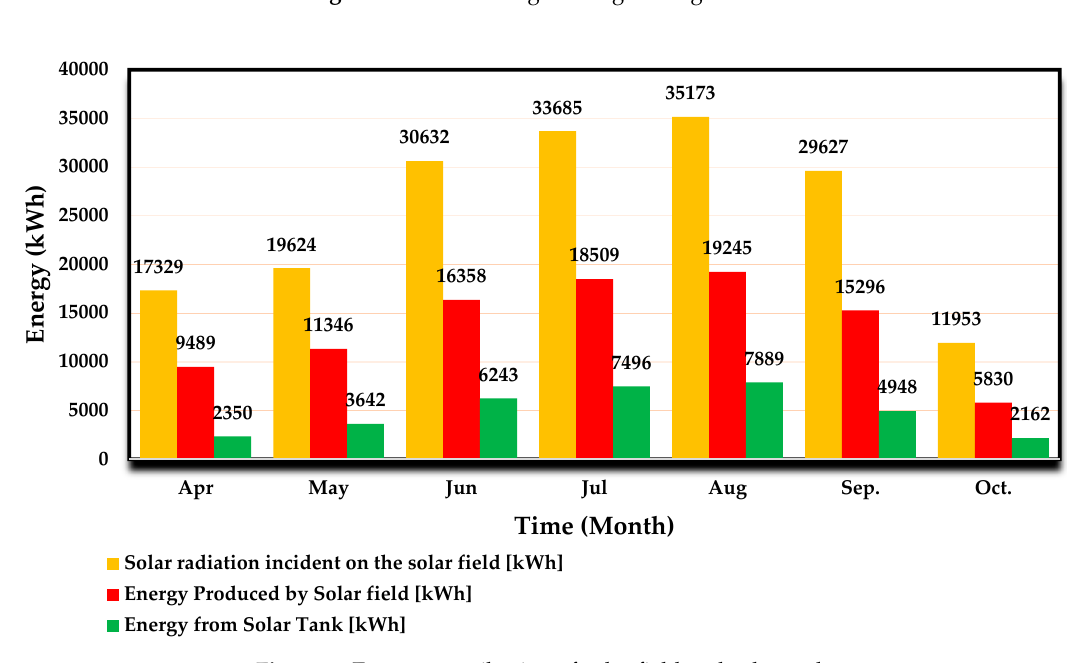
Figure 8. Energy contribution of solar field and solar tank.